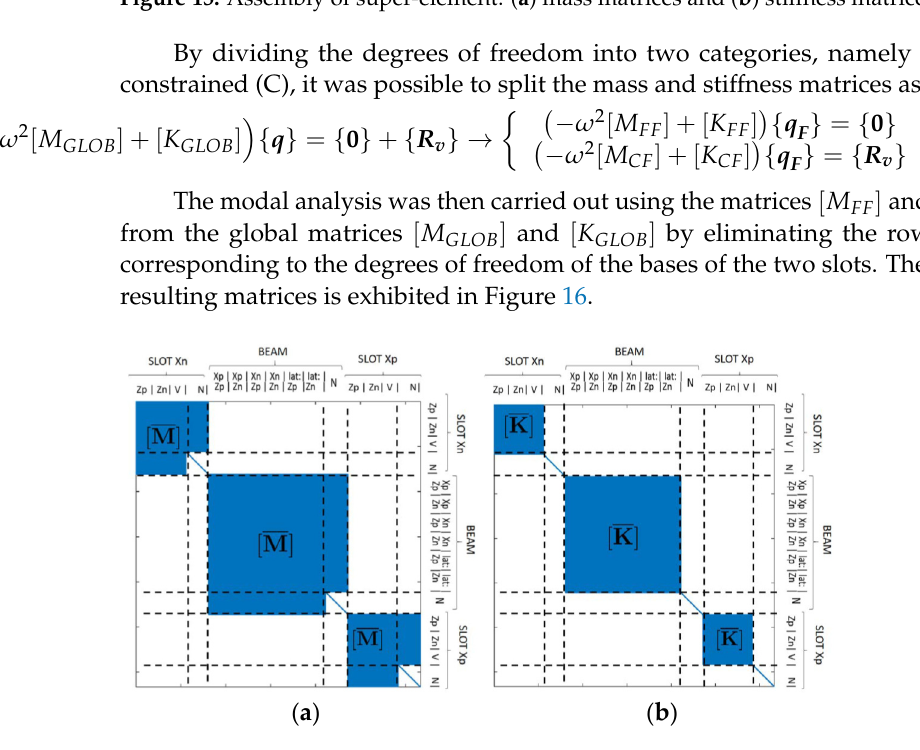
Figure 16. Global matrices considering constraints: ( a ) mass matrix and ( b ) stiffness matrix.